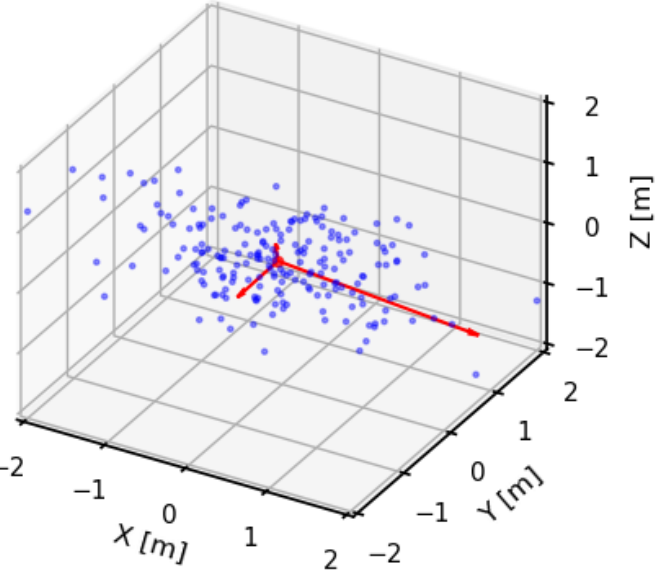
Figure 6. An example subset of a 3D point cloud with corresponding eigenvectors scaled by their